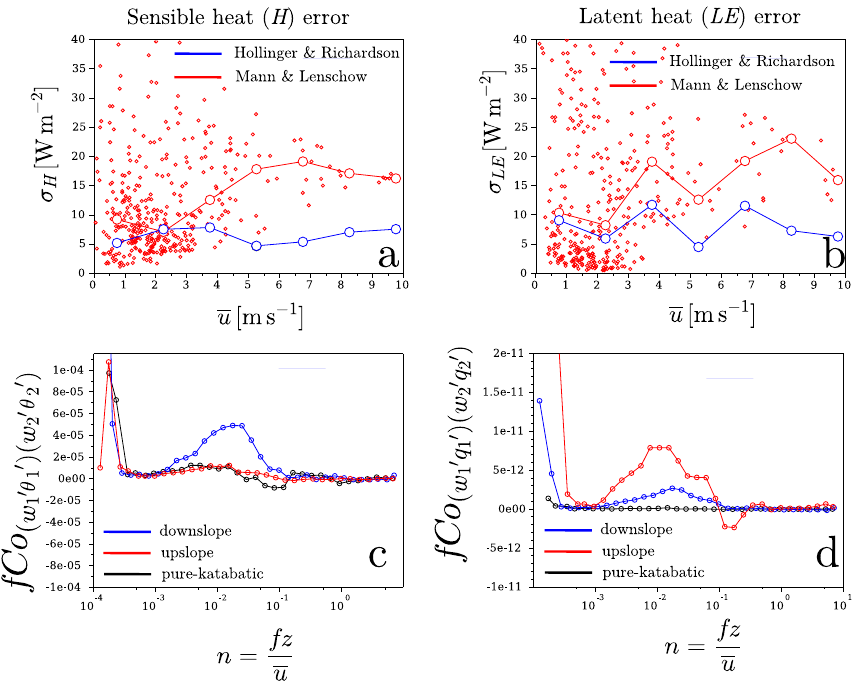
Figure 3. Random error in fluxes derived from the eddy-covariance (EC) method and covariance of fluxes between the two EC systems. (a) Change in the random error (Wm − 2 ) in sensible heat flux H over equally spaced intervals of wind speed (width: 1ms − 1 ). Results are from the Hollinger and Richardson (HR) method (blue line and circles) and the Mann and Lenschow (ML) method (red line and circles). Small red circles indicate estimates of the ML method for individual runs. (b) Results of the the HR and ML methods applied to latent heat LE estimates. (c) Cospectra between the w (cid:48) T (cid:48) time series of both EC systems. Results are for downslope (blue), “upslope” (red) and “pure- katabatic” (black) subsets. Circles indicate medians of cospectral values over equally spaced logarithmic intervals of normalized frequency. (d) Cospectra between the w (cid:48) q (cid:48) time series of both EC systems, using the same notation as for w (cid:48) T (cid:48)